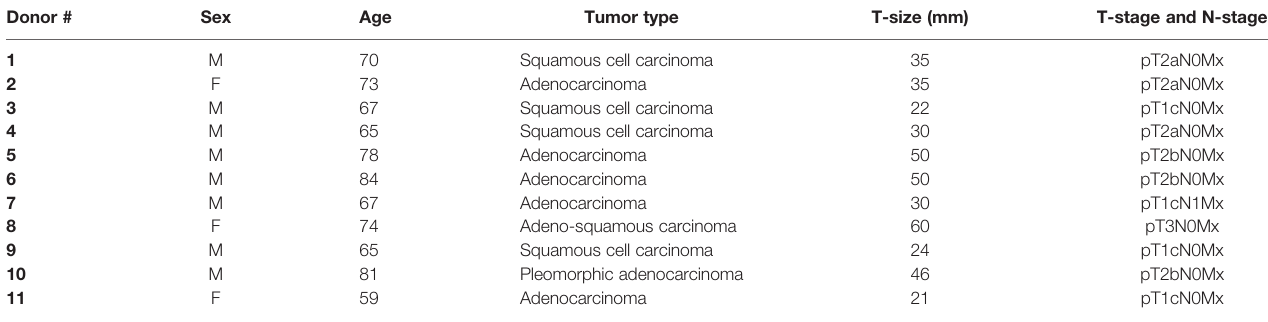
TABLE 1 | Cancer-associated fi broblast (CAF) donor